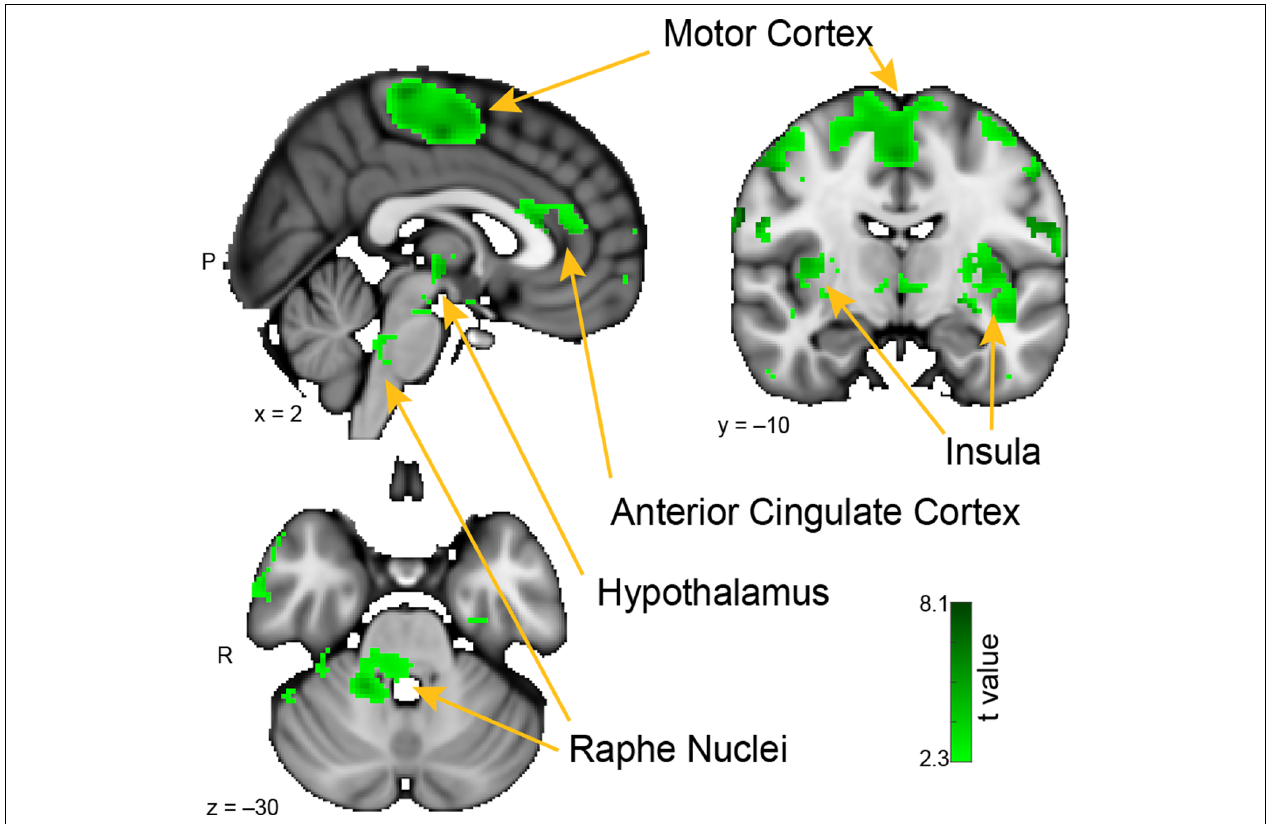
FIGURE 4 | Whole-brain resting connectivity of the MeA. Regions of interest include the insula, motor cortex, anterior cingulate cortex, and raphe nuclei. The connectivity map was thresholded at threshold-free cluster enhancement corrected P < 0.05. Results are overlaid on FSL’s MNI152_T1_1